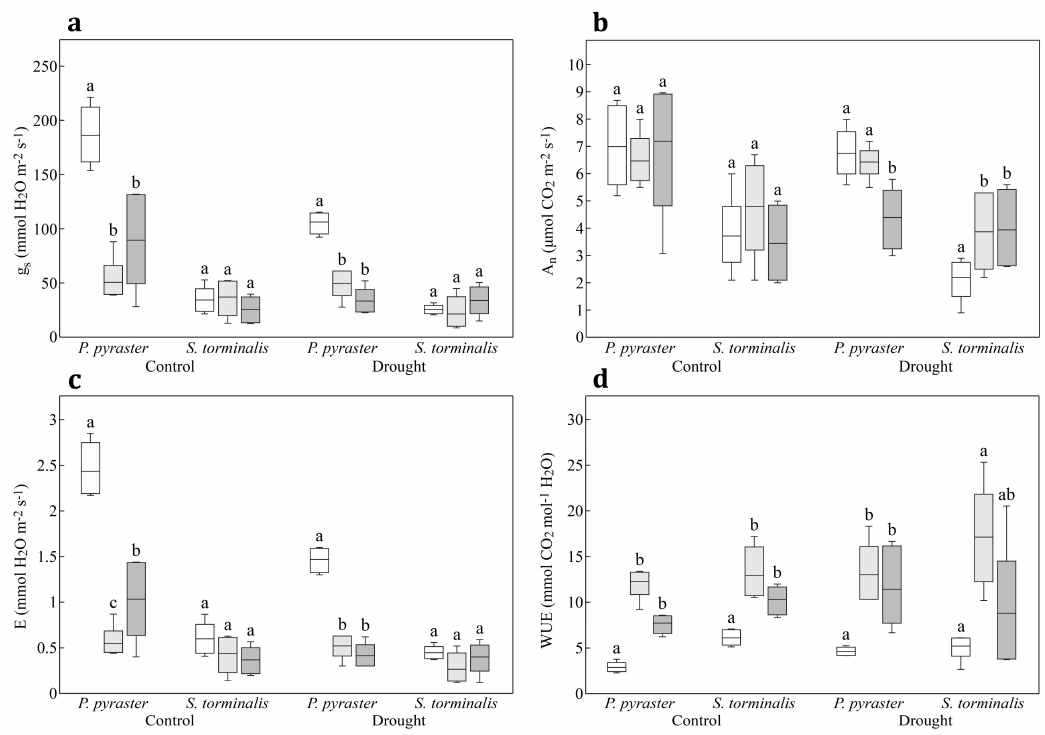
Figure 4. Box plots for ( a ) stomatal conductance (g s ); ( b ) net photosynthetic rate (A n ); ( c ) transpiration rate (E); and ( d ) water use e ffi ciency (WUE) for seedlings of P. pyraster and S. torminalis measured after 30 days (white bars), 40 days (light grey bars), and 50 days (dark grey bars) of di ff erent water